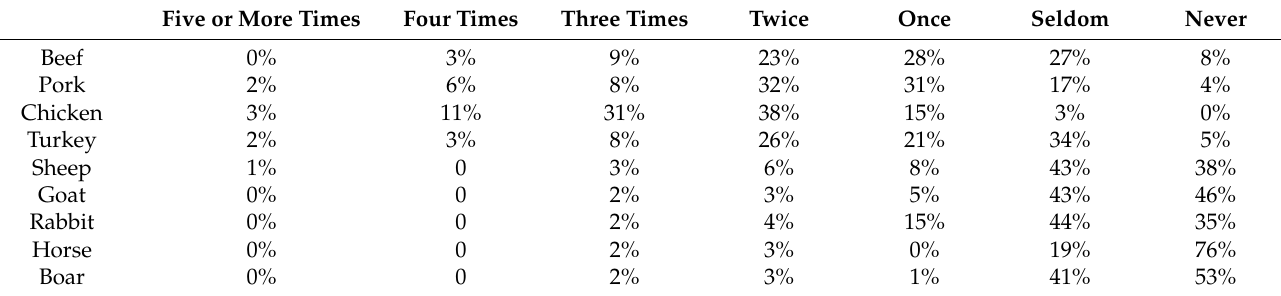
Table 2. Weekly meat consumption.